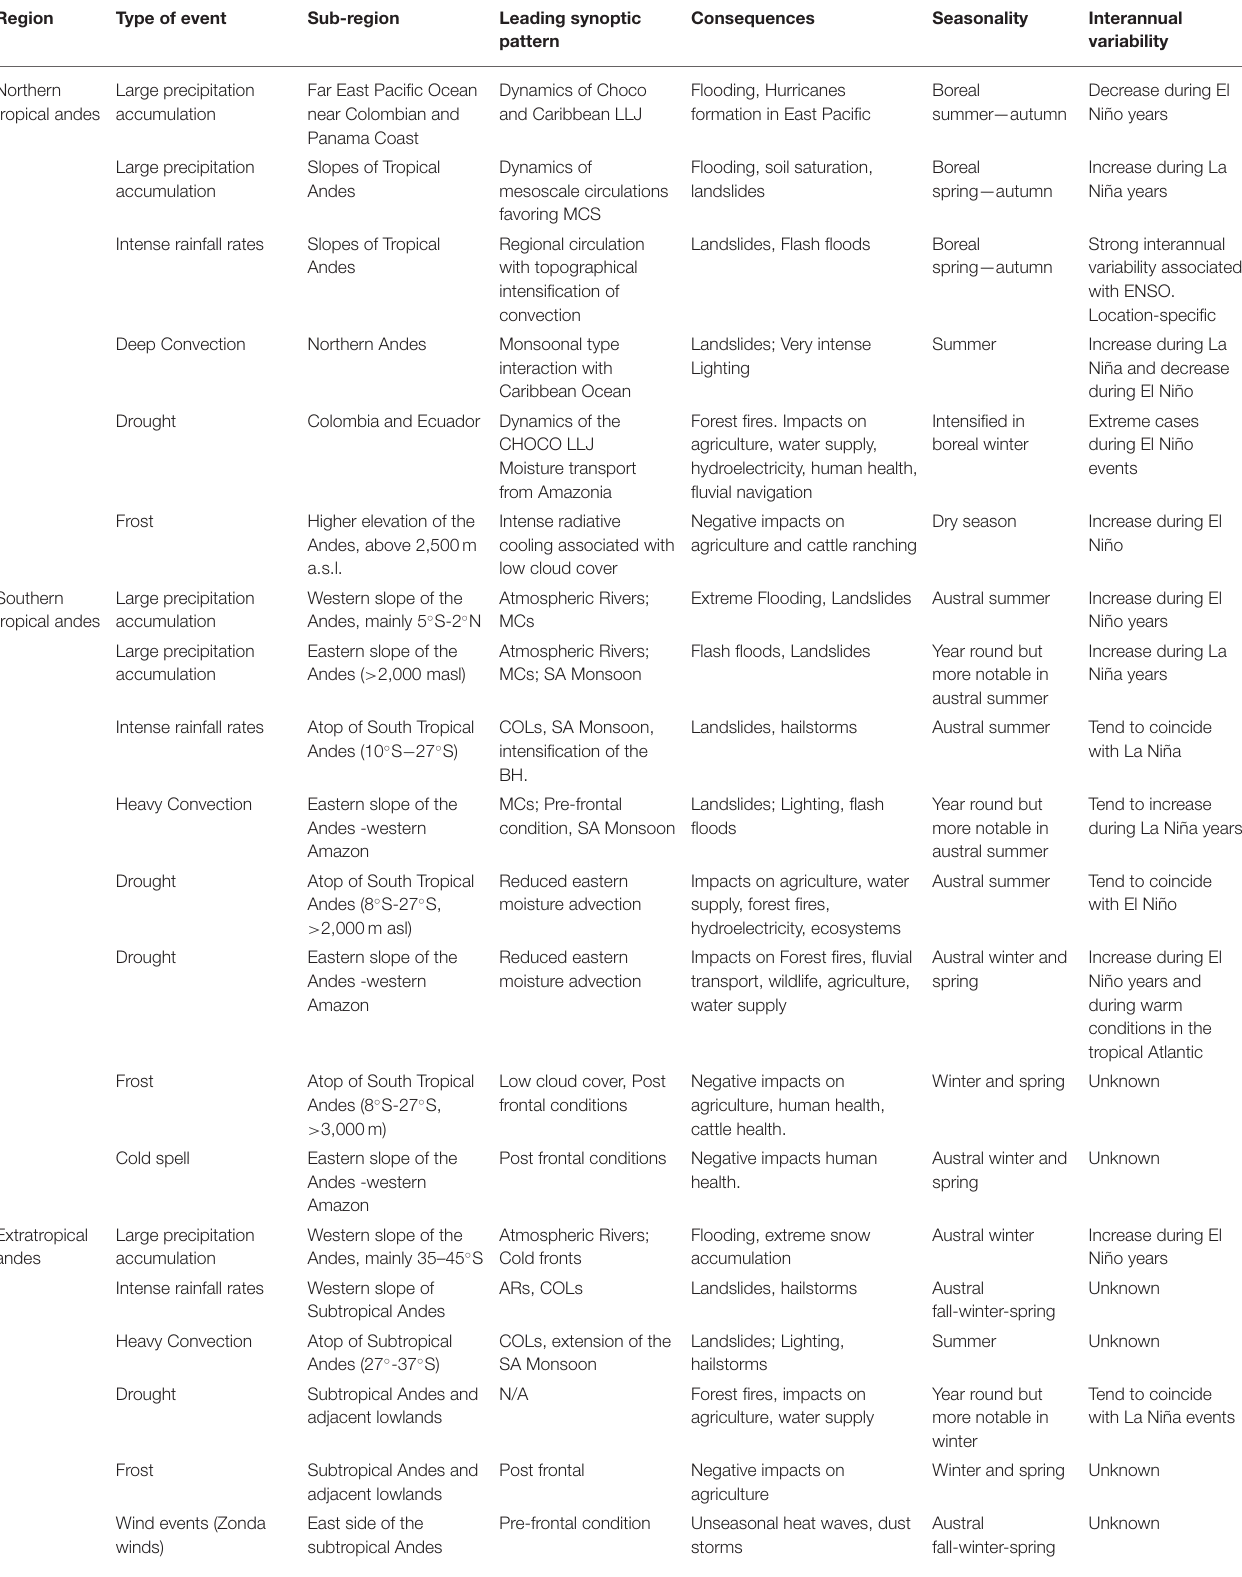
TABLE 1 | Summary of High-Impact Weather Events in the Andes.